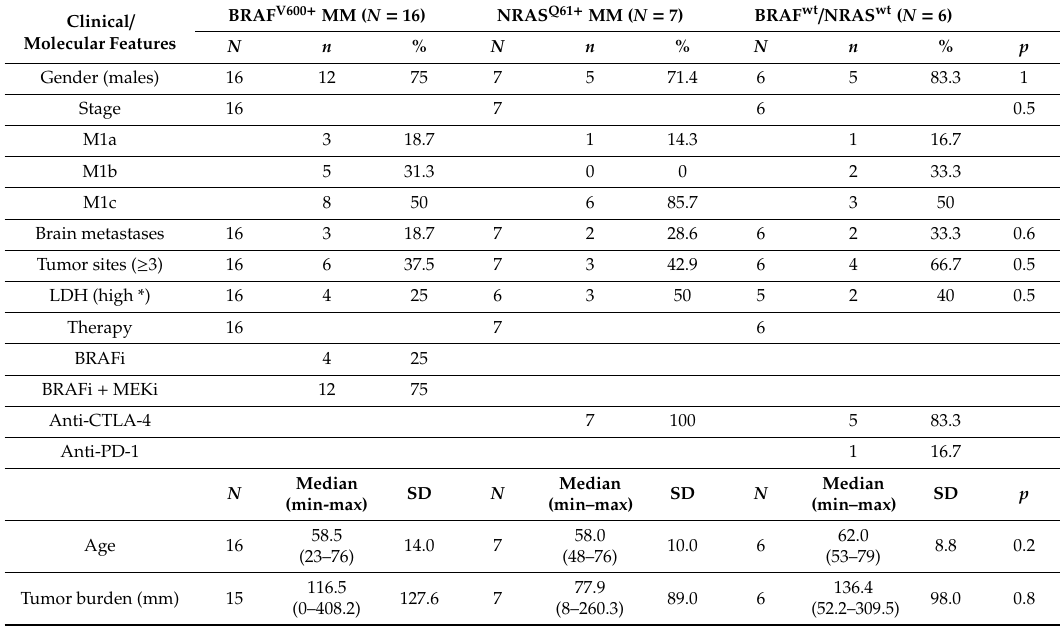
Table 1. Clinical and molecular features of the study cohort at baseline (T0; N = 29). Clinical / Molecular